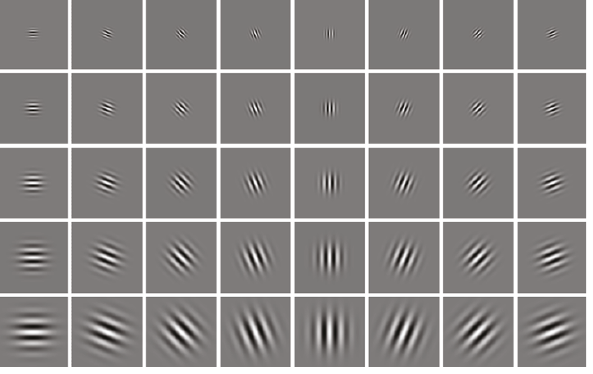
Figure 2: The real parts of the Gabor filter bank commonly used for feature extraction in the field of face